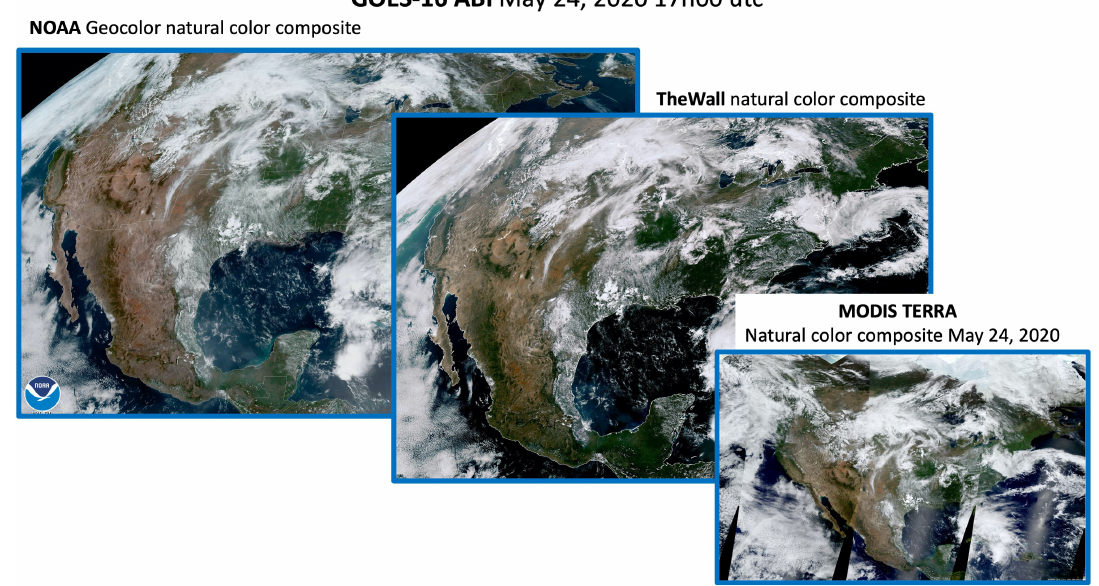
Figure 13. Comparison of our GOES-16 true natural color RGB composite to the GeoColor natural color composite and MODIS data, all taken over North America on 24 May